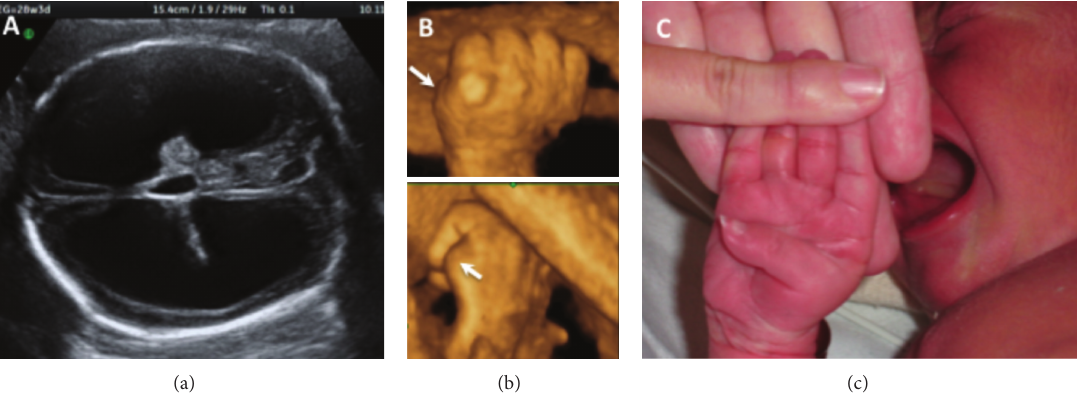
Figure 2: Case 2. (a) Two-dimensional ultrasound view shows severe triventricular hydrocephaly at 28 weeks. (b) Upper and lower panel, surface-rendered three-dimensional ultrasound view shows adducted thumb in the fetus (arrows). (c) Picture of the newborn infant shows adducted